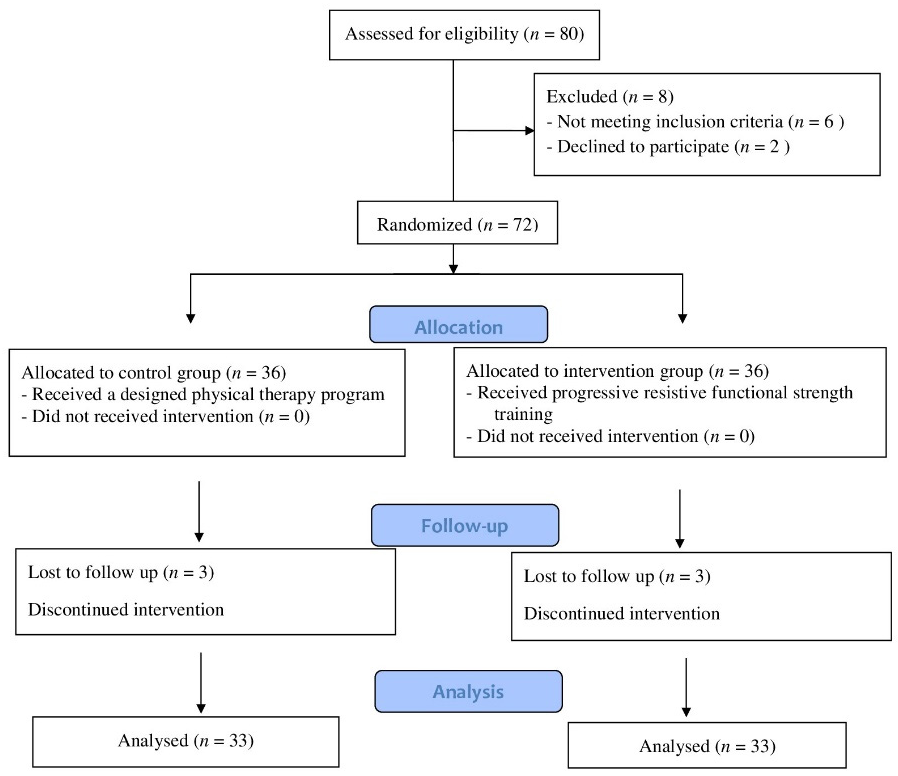
Figure 1. Children’s consort flow diagram .